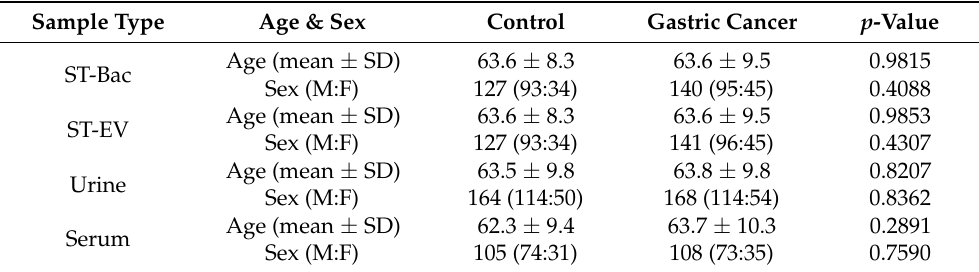
Table 1. Basal clinical characteristics of each sample